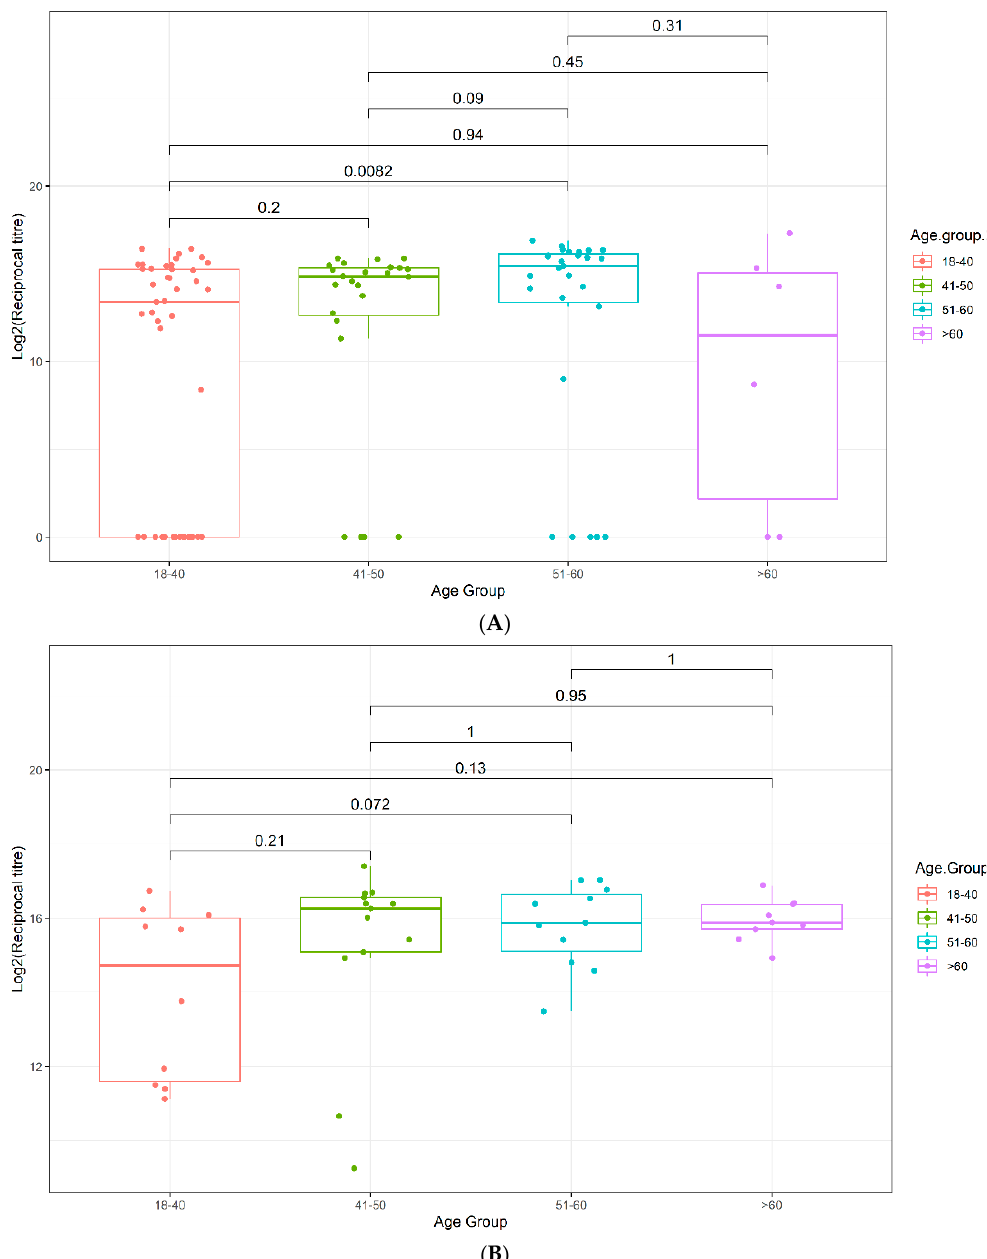
Figure 3. Box plots displaying the antibody reciprocal titers as a function of age. ( A ) Validation Cohort 2, ( B ) Multi-ethnic Cohort 3. p -values were determined using the Wilcoxon test (unpaired, two-tailed).